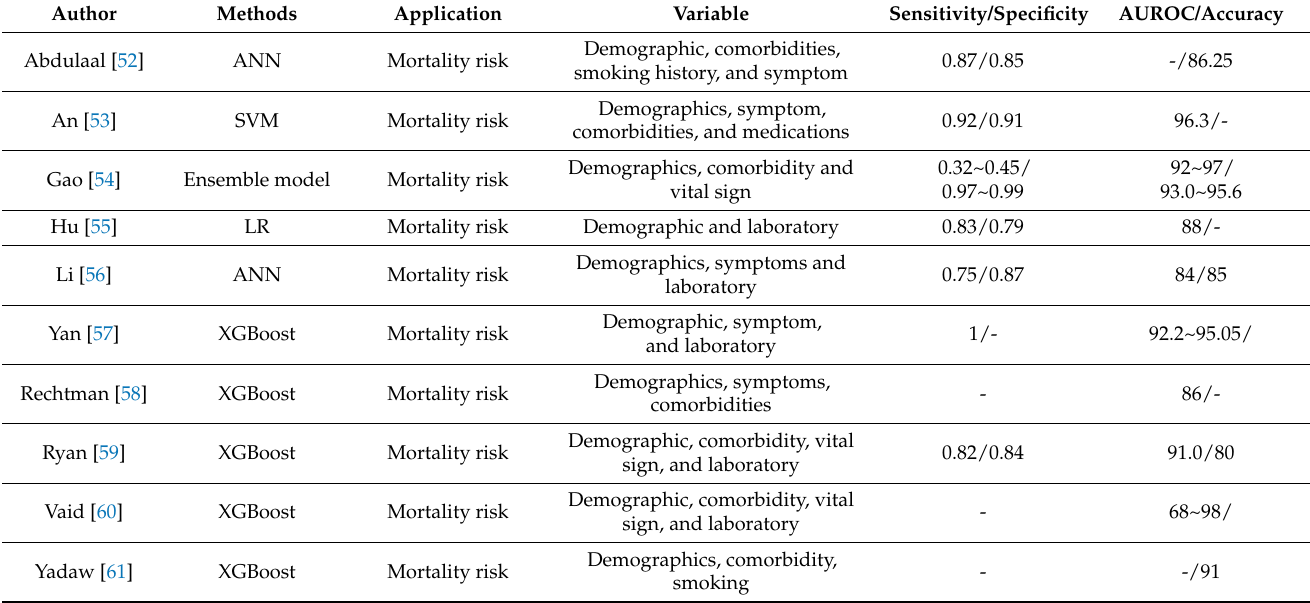
Table 3. The performance of AI model to predict mortality of